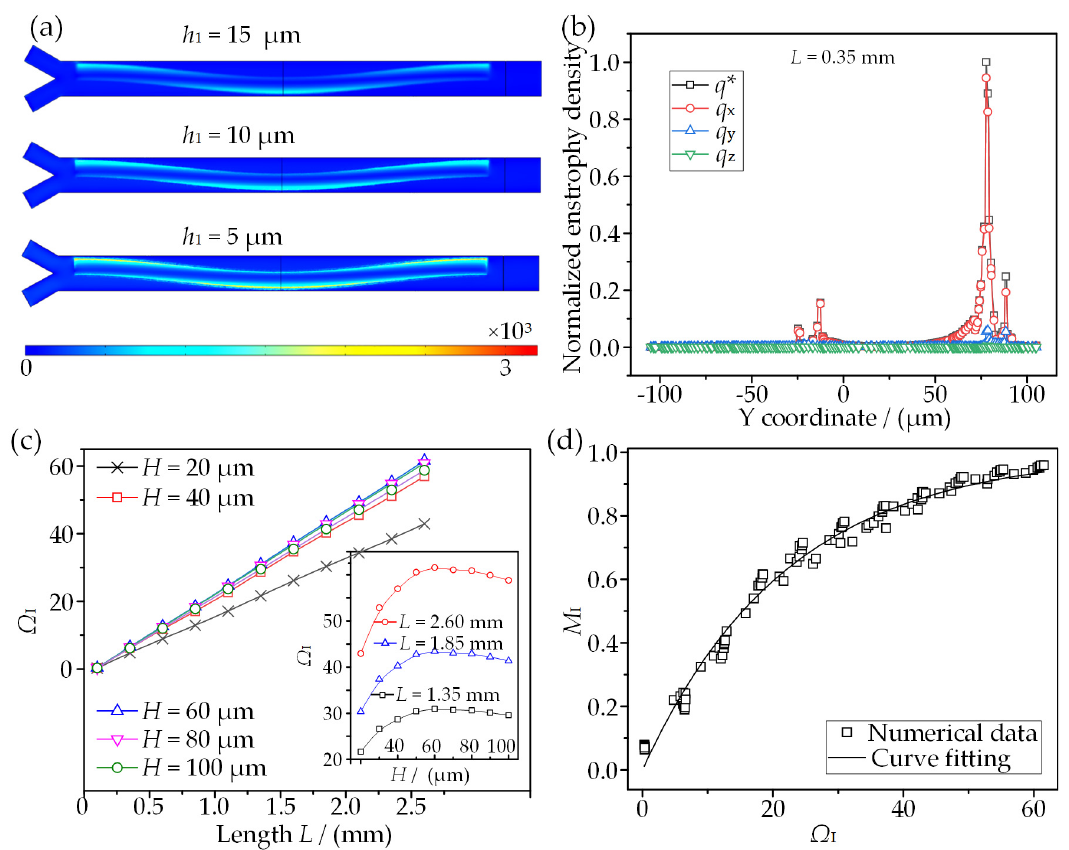
Figure 5. Analysis of the relation between vorticity and mixing performance: ( a ) distributions of vorticity magnitude in three cross sections; ( b ) profiles of mean enstrophy density and its three components; ( c ) variations of Ω I along the mixing length under different H values; ( d ) variations of MI with respect to Ω I .